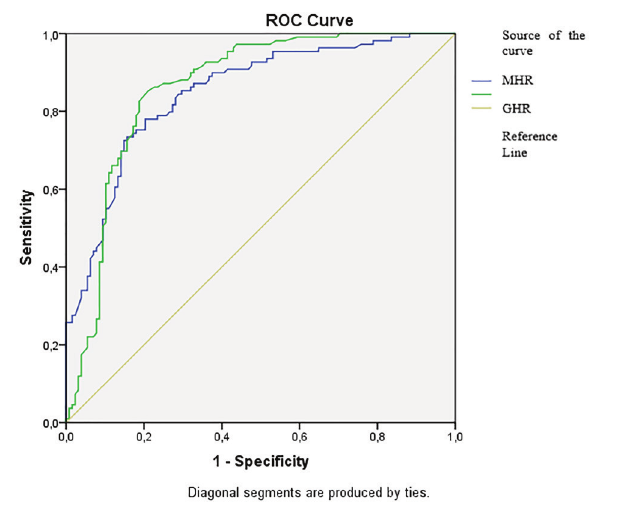
Figure 3 - The receiver–operator characteristic (ROC) curve to determine the best cut-off values of GHR and MHR in predicting of CSF